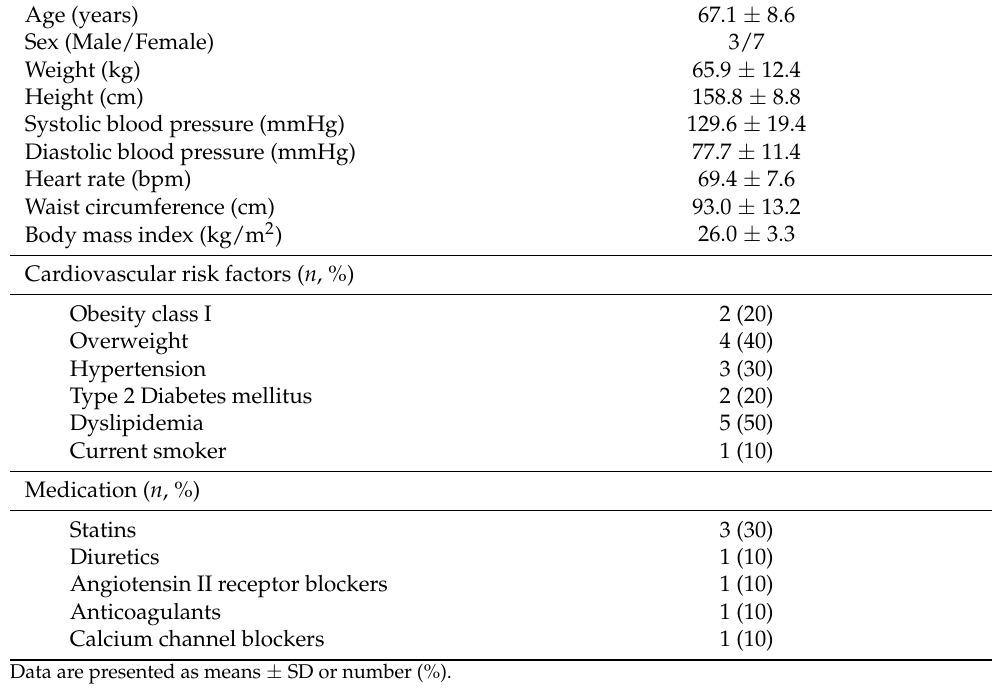
Table 1. Characteristics of the Participants